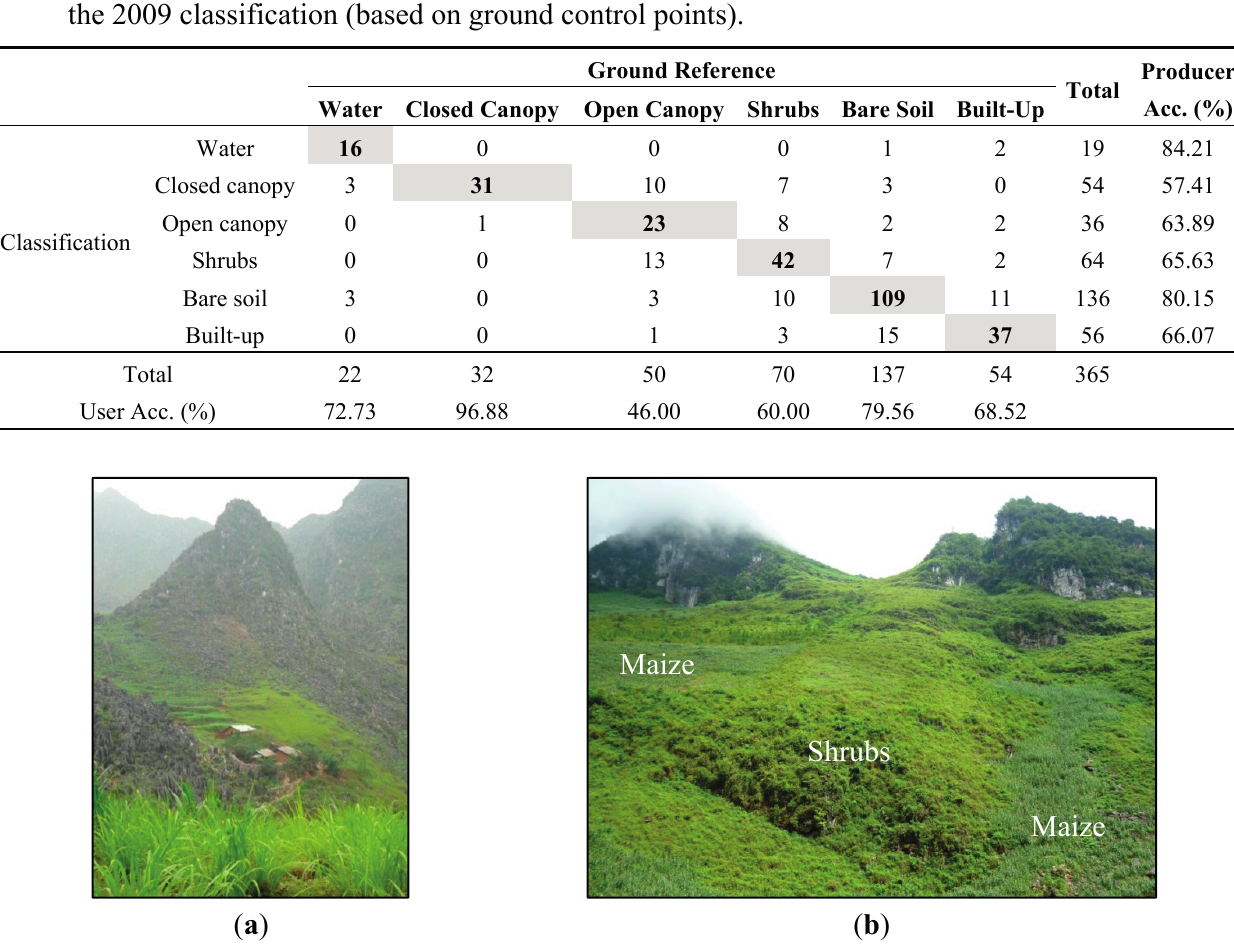
Figure 3. ( a ) Typical karst landscape and ( b ) mixture of maize and shrubs in Đồ ng V ă n District, Hà Giang Province. (Photo credit: Sarah Turner and Lê M ạ nh